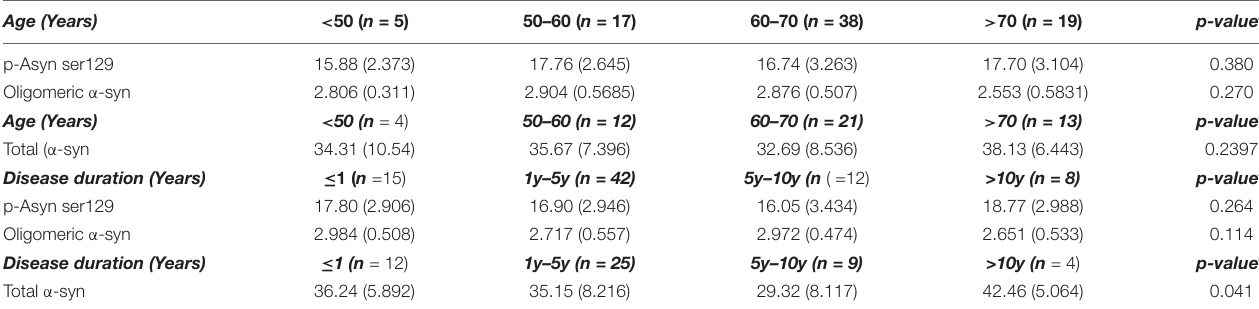
TABLE 2 | Correlation Lewy body-associated proteins with age and disease